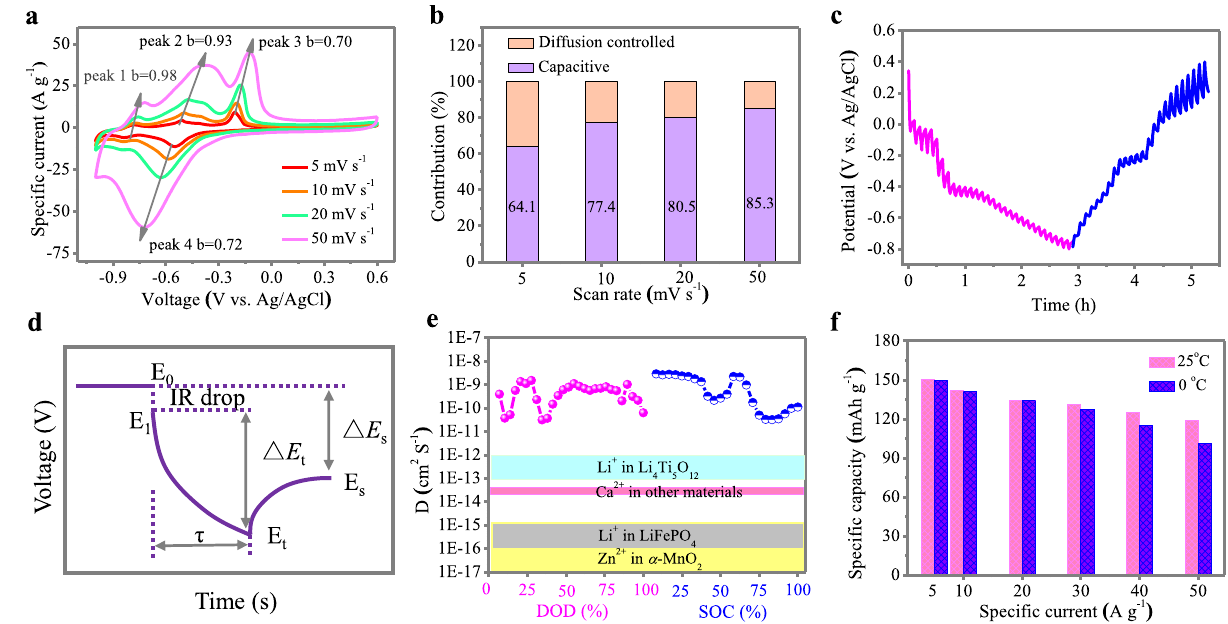
Fig. 3 Reaction kinetics of the PT anode in a three-electrode cell. a CV plots of PT anode in 1M CaCl 2 at scanning rates from 5 to 50 mV s − 1 . b Contribution ratio of the capacitive- and diffusion-controlled process at various scan rates. c GITT curves of PT anode during discharge and charge. d The key parameters for diffusion coef fi cient calculation. e The calculated Ca 2 + ion diffusion coef fi cient during discharging and charging process and comparison with other systems. f Speci fi c capacities of PT in 1M CaCl 2 at room temperature and 0